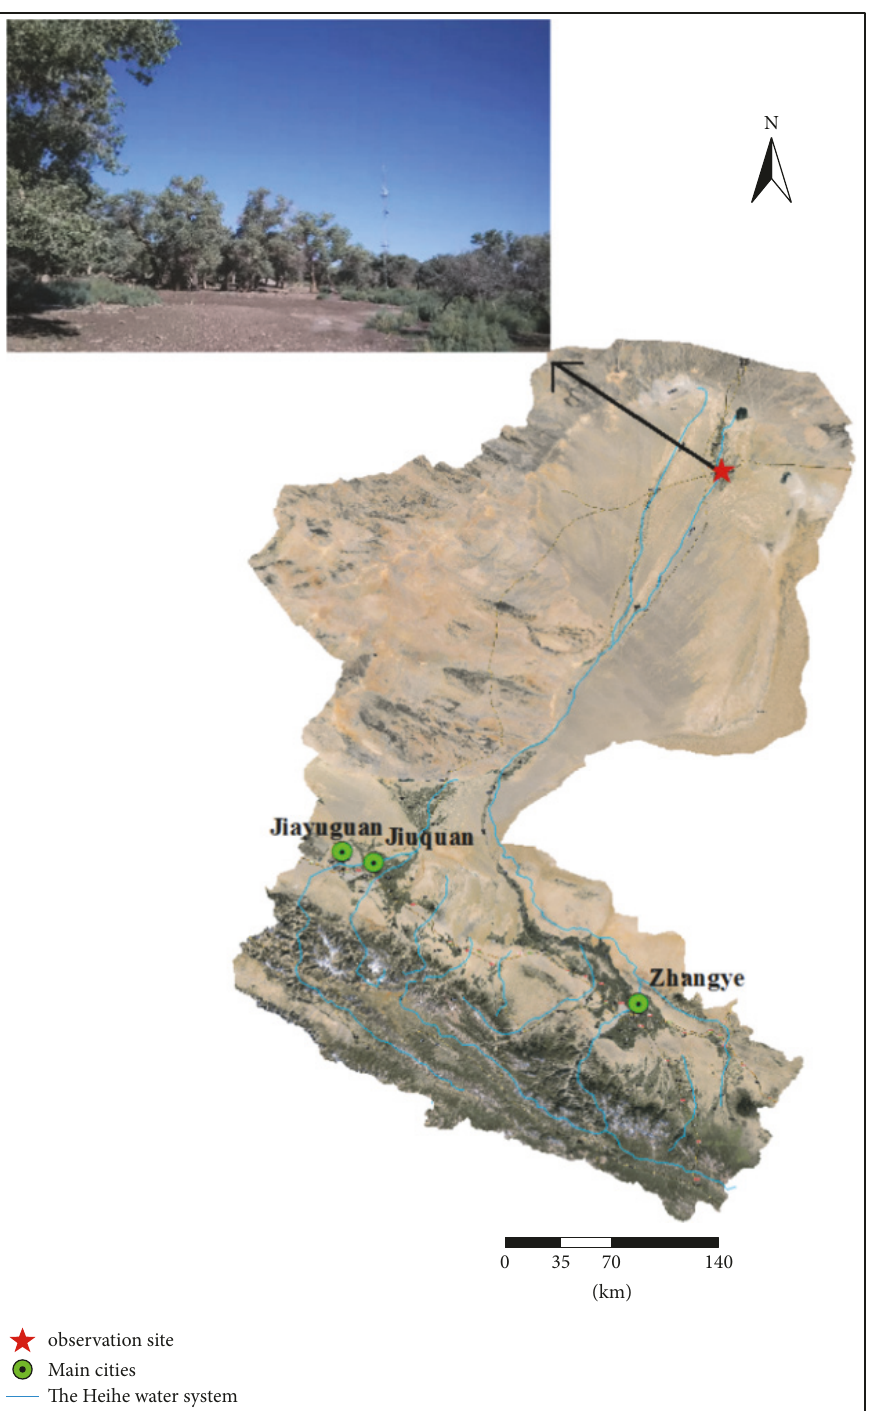
Figure 1: Location and photograph of observation